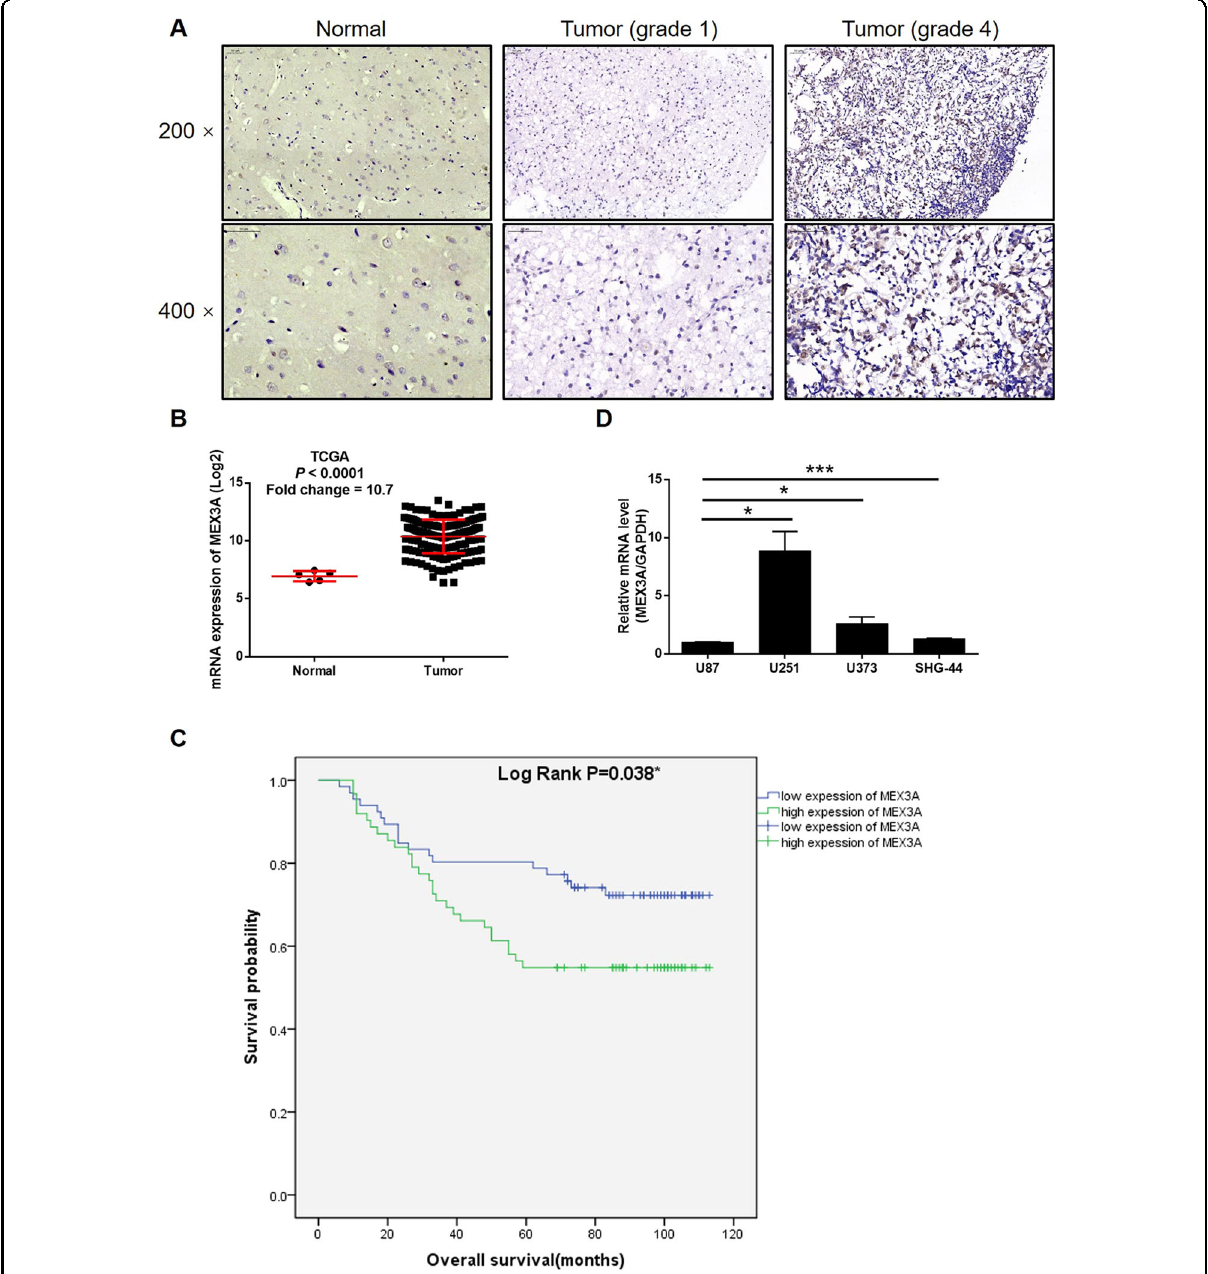
Fig. 1 MEX3A was upregulated in glioma tissues and expressed in glioma cells. A The expression level of MEX3A was detected by IHC analysis in glioma and normal tissues. B The mining of RNA-seq data of TCGA showed the upregulated mRNA expression of MEX3A in tumor tissues of glioma patients compared with that in normal tissues. C The association between MEX3A expression and prognosis of glioma patients was evaluated with Kaplan – Meier survival analysis. D The mRNA expression of MEX3A in U87, U251, U373, and SHG-44 cell lines was detected by qPCR. The representative images were selected from at least three independent experiments. Data were shown as mean ± SD. * P < 0.05, ** P < 0.01, *** P <